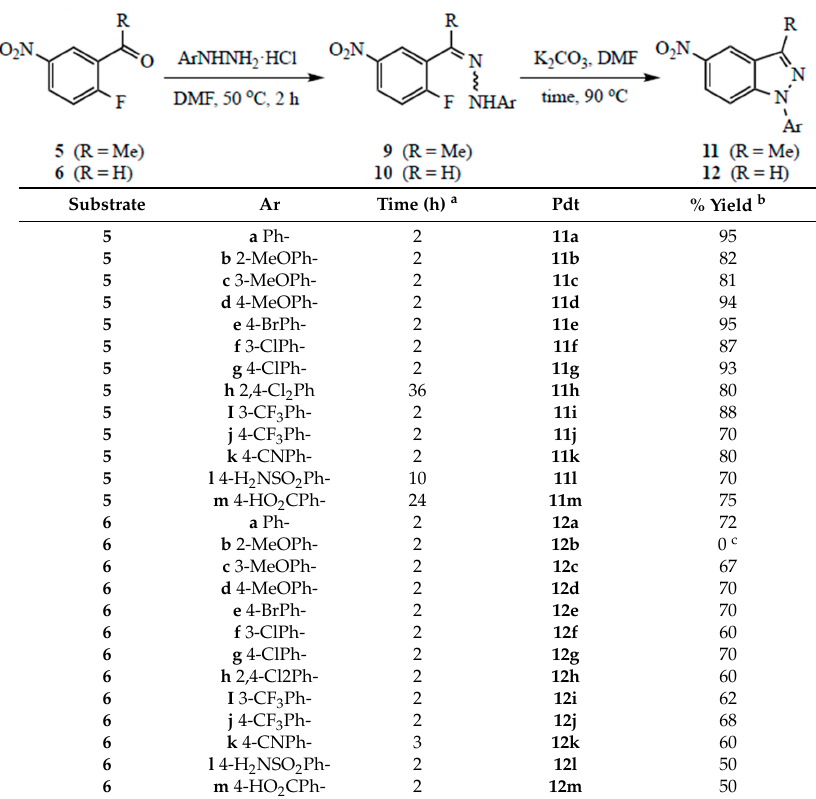
Table 1. Yields for the two-step synthesis of 1-aryl-5-nitro-1 H -indazoles.